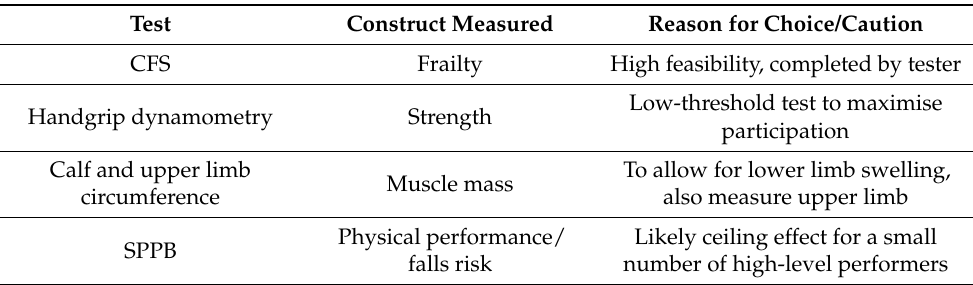
Table 4. Proposed test battery to evaluate physical functioning limitations in people who are